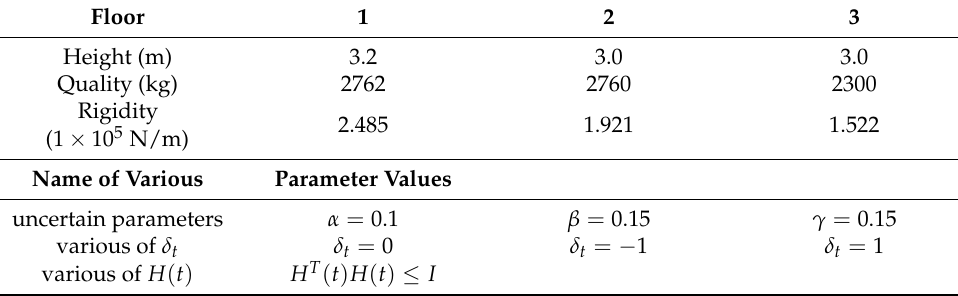
Table 2. Structural parameters of the uncertain